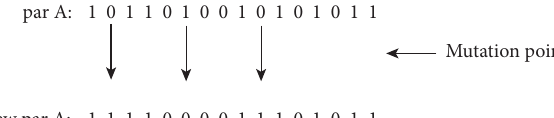
Figure 3: Parameters sets gene mutations generate new parameters